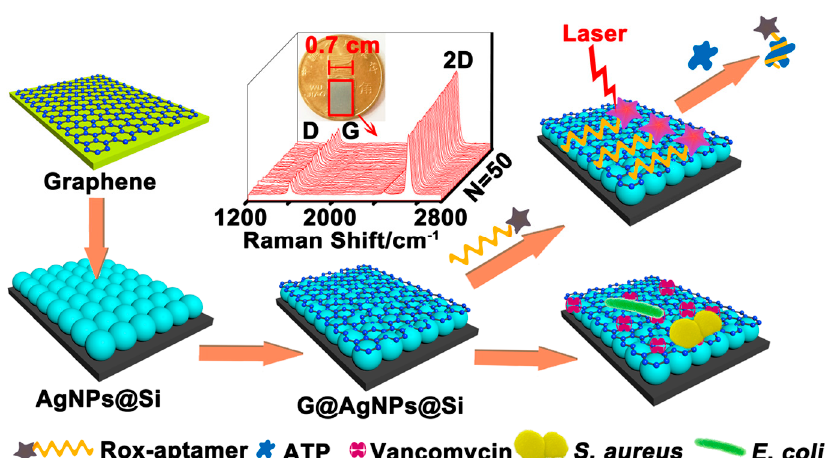
Figure 5. Schematic of the chip system for the analysis of ATP and bacteria [133]. Reproduced with permission from [133]. American Chemical Society, 2018.